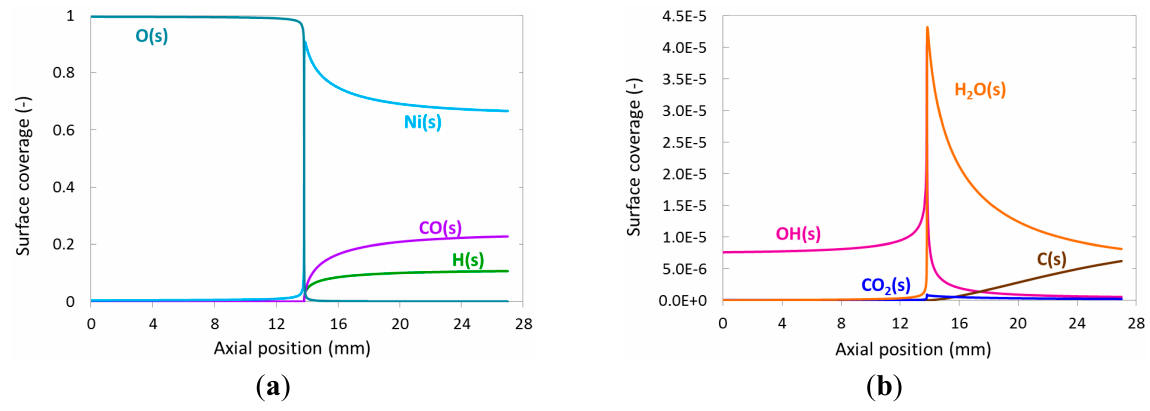
Figure 5. Computed surface coverage of adsorbed species: ( a ) O(s), CO(s), H(s), Ni; ( b ) OH(s), H 2 O(s), CO 2 (s), and C(s) along the catalytic bed at 973 K, 4 slpm CH 4 /O 2 = 1.6 and 1